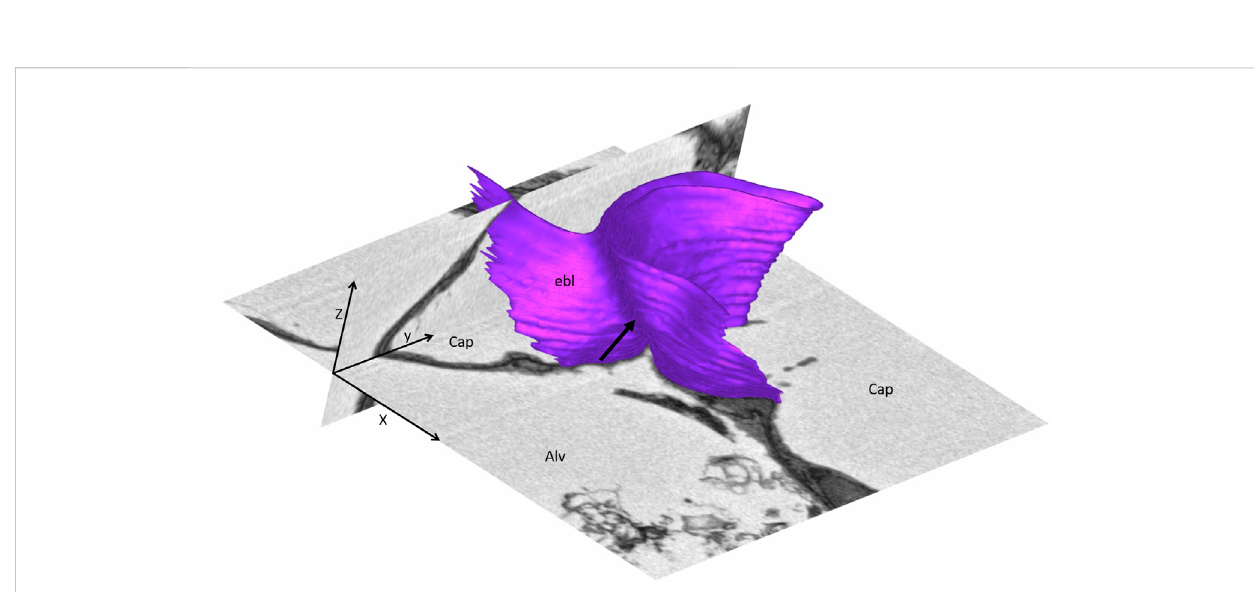
FIGURE 9 Three-dimensional model of a pleat: The mouse lung was fi xed in situ by vascular perfusion via the right ventricle at an airway opening pressure of 2 cmH 2 O on expiration after two recruitment maneuvers (3 s pause at 30 cmH 2 O) (Ruhl et al., 2019) and processed for serial block-face scanning electronmicroscopy(SBF-SEM)(Buchackereta.2019).TheEMimagestackwasusedtosegmentthesharedbasementmembraneoftheendothelialand alveolar epithelial type I cell (ebl, magenta) within a pleat. The arrow points at the slit-like entrance to the pleat, which is created by the blood-gas barrier and invaginates sickle-shaped into the capillary (Cap). The model of the pleat is put into the context of the EM stack by two-dimensional